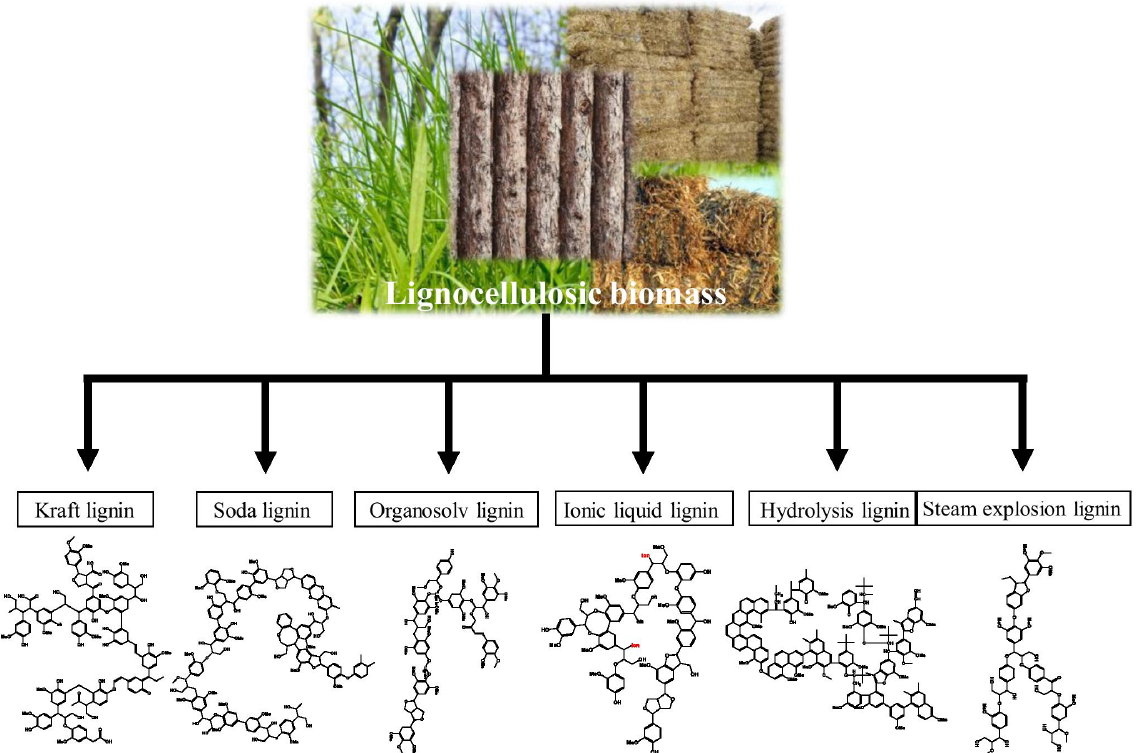
Figure 3. Di ff erent structures of lignin extract from lignocellulosic biomass with various processes [24]. Table 1. Several types of lignin and their extraction